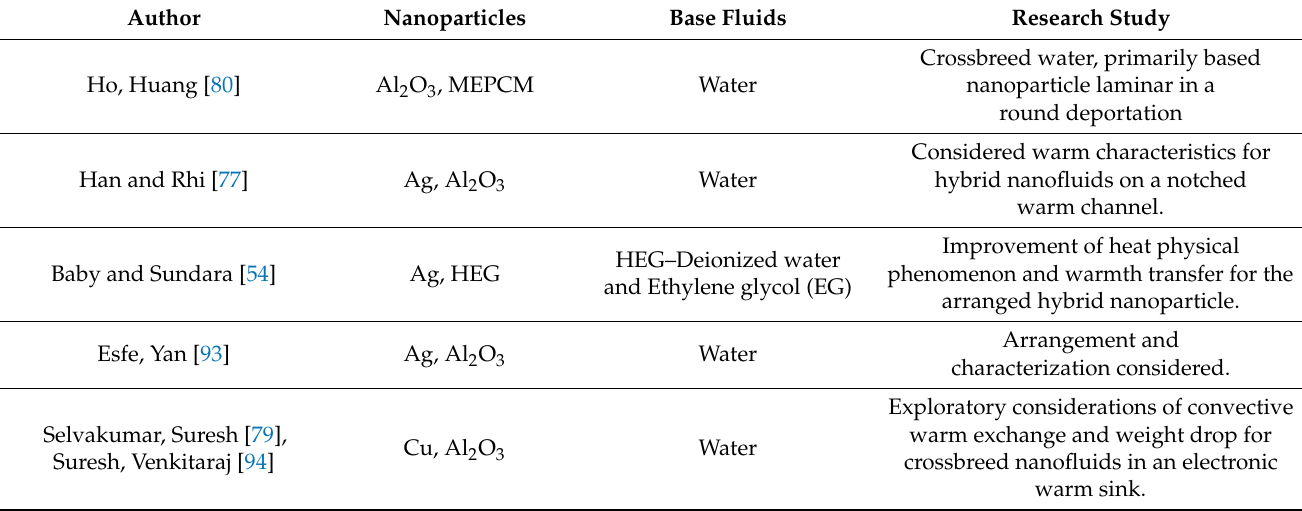
Table 2. Previous research works are based on hybrid